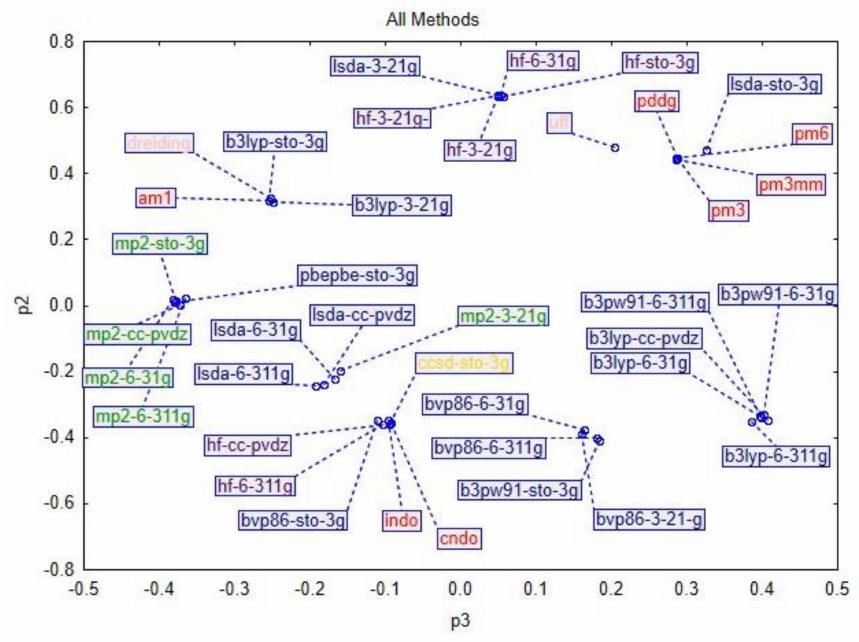
Figure 4. Score plot showing the distribution of the methods in the principal components p2 and